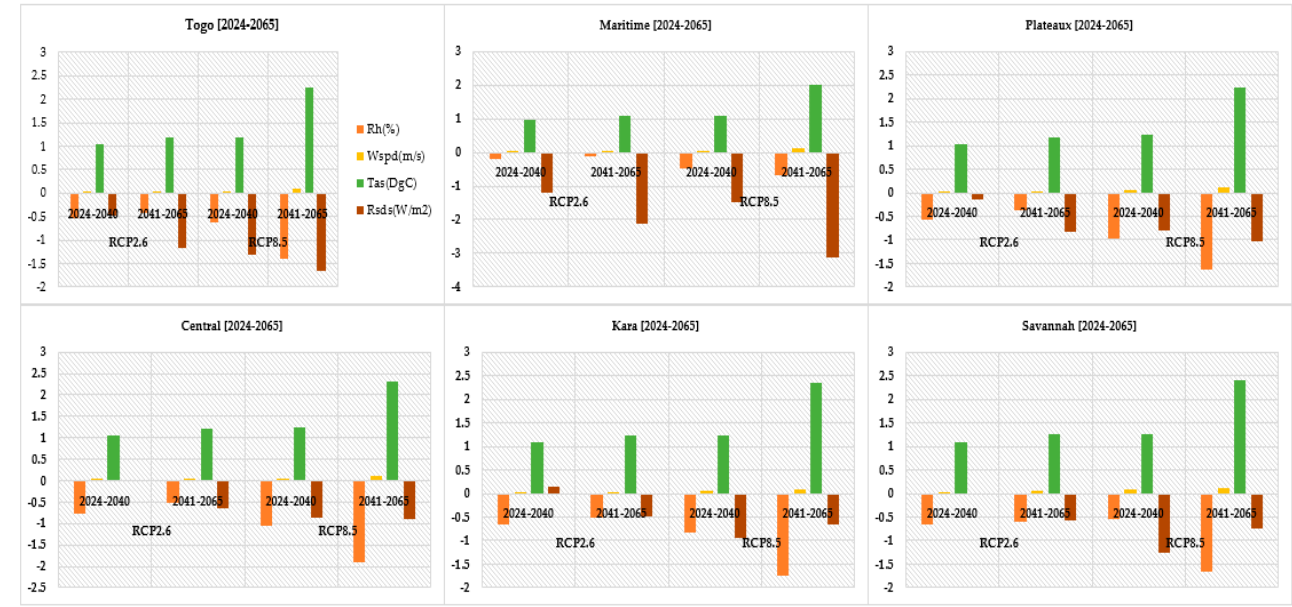
Figure 6. Climatological mean variation of Rh, Wspd, Tas and Rs over Togo under RCP2.6 and 8.5 scenarios during 2024–2040 and 2041–2065.